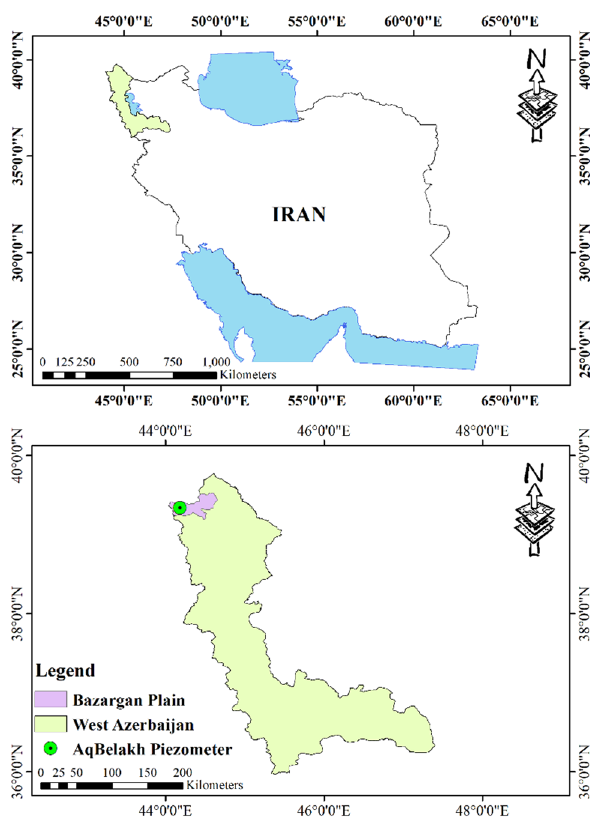
Fig. 1 Geographical location of the studied piezometer in Iran